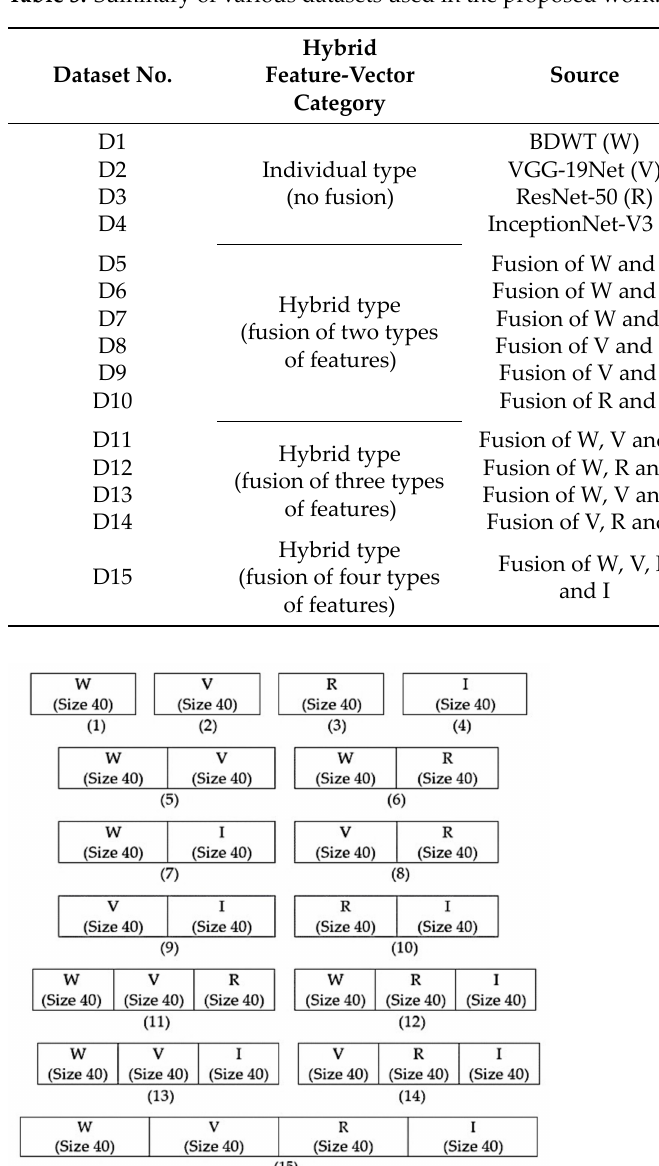
Table 3. Summary of various datasets used in the proposed work.